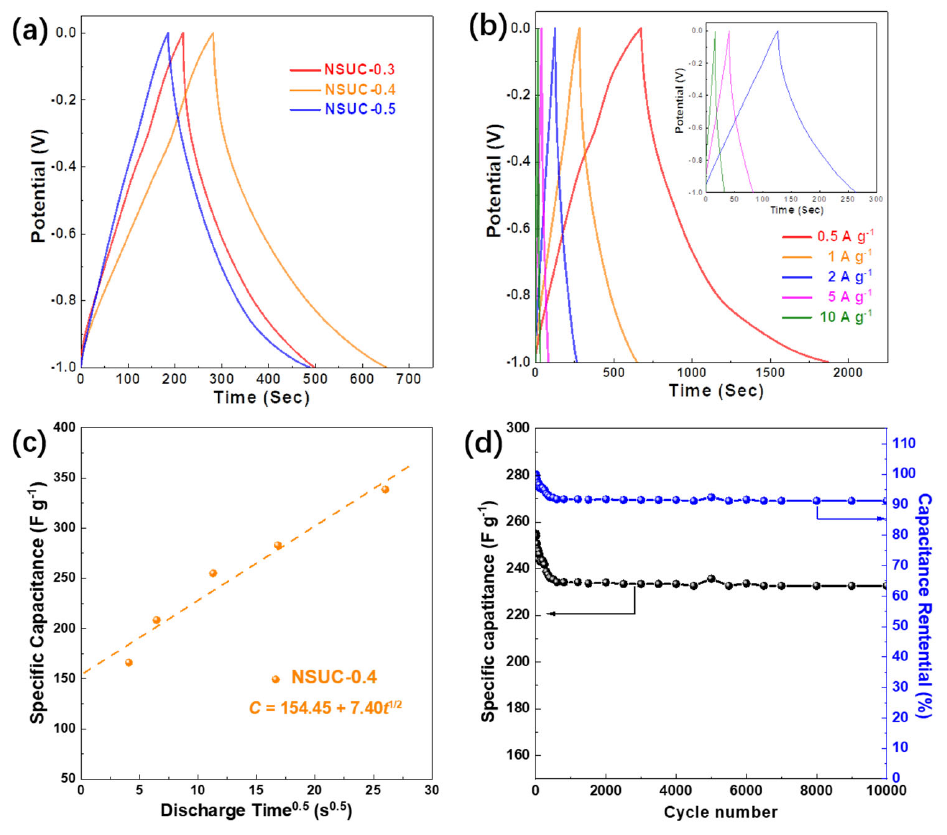
Figure 6. ( a ) GCD curves at 1 A g − 1 , ( b ) GCD curves of NSUC ‐ 0.4 at different current densities, ( c ) capacitance of NSUC ‐ 0.4 versus the square root of discharge time and ( d ) cyclic stability of NSUC ‐ 0.4 at 2 A g − 1 . Table 2. Comparison of the electrochemical performances of the reported carbon ‐ based electrodes in three ‐ electrode system.